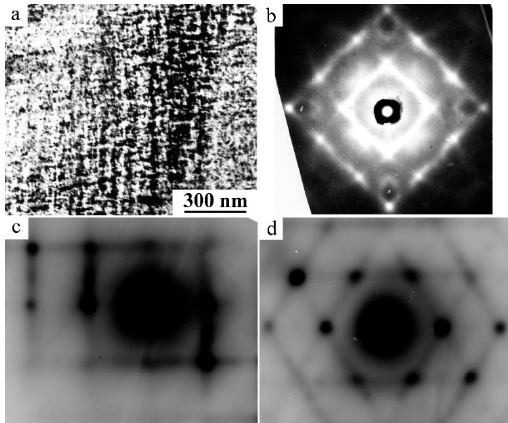
Figure 2. Typical image of ( a ) tweed TEM contrast and ( b – d ) diffuse scattering of single-crystalline alloys of titanium nickelide; ( b ) X-rays and ( c , d ) selected area electron diffraction (SAED) [4,6].